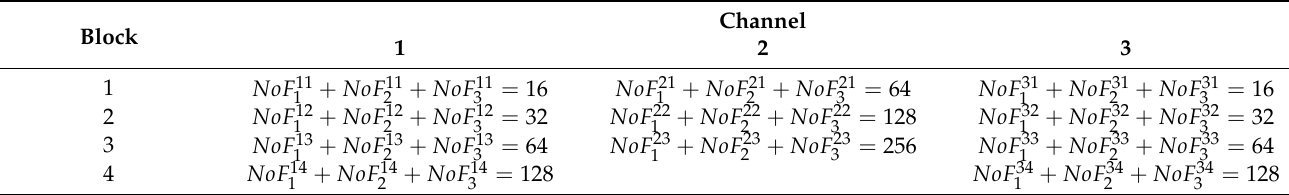
Table 3. The total number of filters in each multi-scale block.